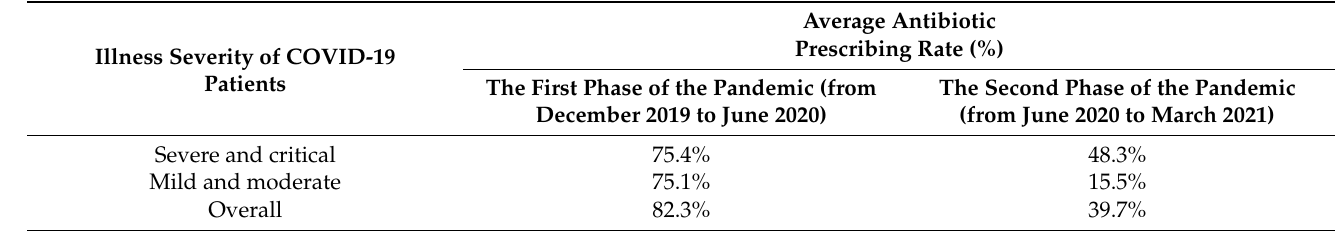
Table 3. Comparison of antibiotic prescribing rates by severity of COVID-19 illness in COVID-19 patients over the time of the pandemic.